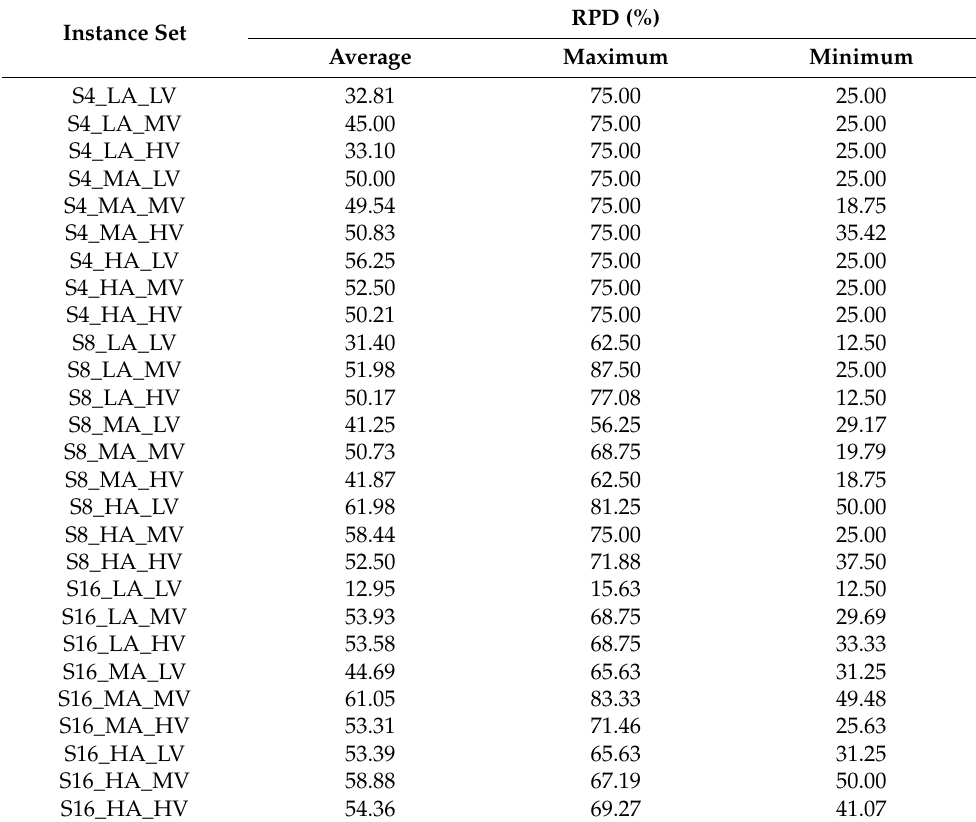
Table 5. Average, maximum, and minimum RPD (%) values obtained by the evolutionary algorithm for each instance